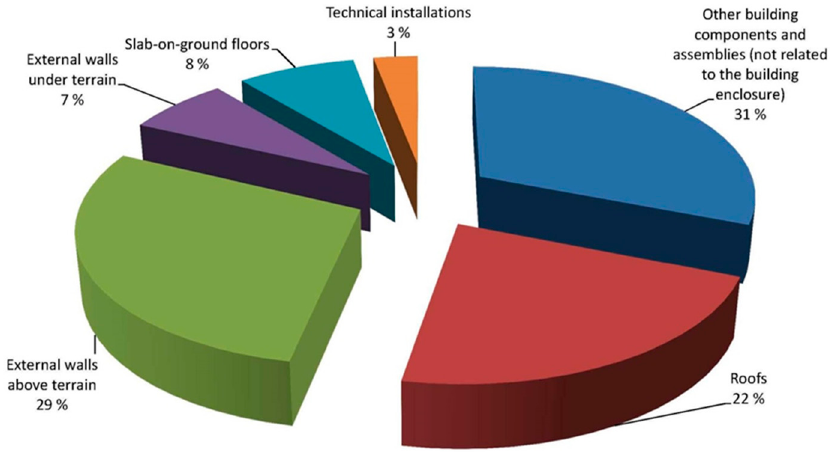
Figure 5. Process-induced building defect cases for the 10-year period from 1993–2002 (a total of Figure 5. Process ‐ induced building defect cases for the 10 ‐ year period from 1993–2002 (a total of 2423 2423 building defect cases), distributed by localization of defects building defect cases), distributed by localization of defects [12].